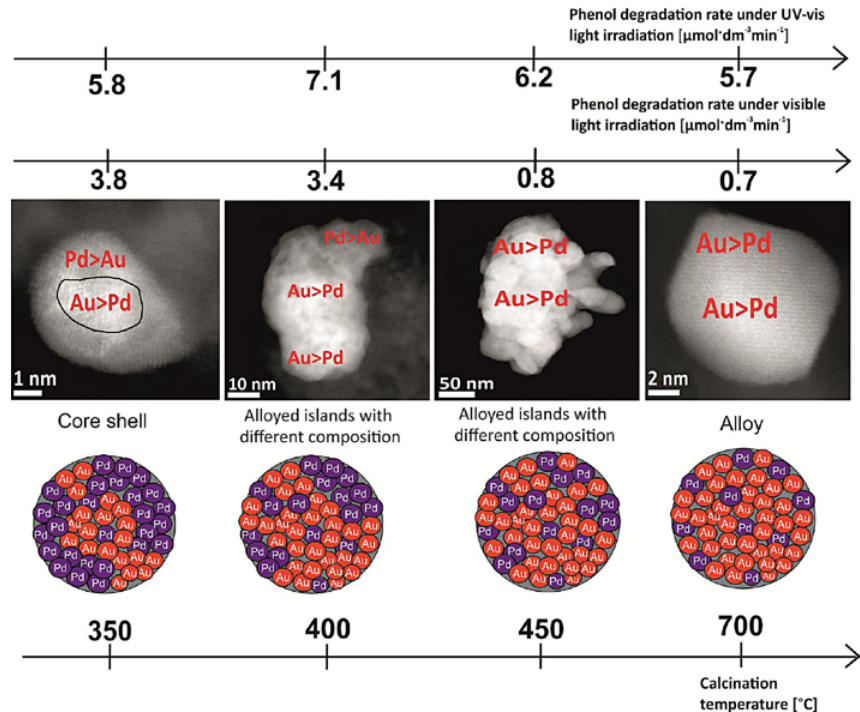
Figure 9. The effect of calcination temperature on the structure of Au/Pd bimetallic nanoparticles and Figure 9. The e ff ect of calcination temperature on the structure of Au / Pd bimetallic nanoparticles and photoactivity of Au/Pd-TiO 2 nanocomposites. Reprinted with permission from [135]: Cybula, A. et al. photoactivity of Au / Pd-TiO 2 nanocomposites. Reprinted with permission from [135]: Cybula, A.; et